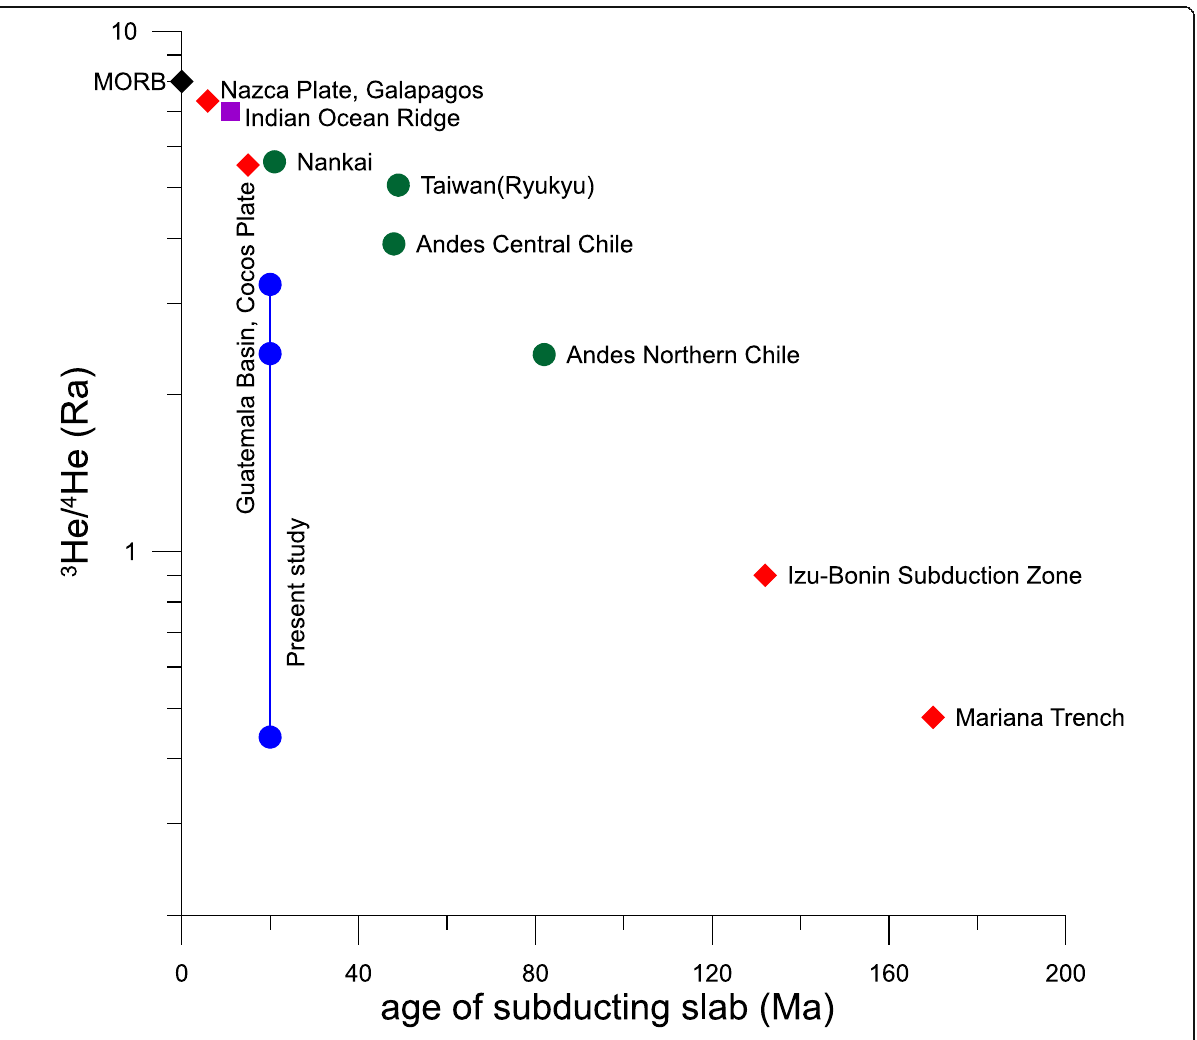
Fig. 6 Mean Ra values from arc-related fluids worldwide versus age of the subducted sediment. Data from Hilton et al. 2002 (green circles), Moreira et al. 2003 (purple square) and Chavrit et al. 2016 (red diamonds). The trend to lower helium isotope ratios with increasing slab age is due to a combination of mantle helium lost and ingrowth of radiogenic helium. Own data (blue circles) show additional input of crustal helium from another